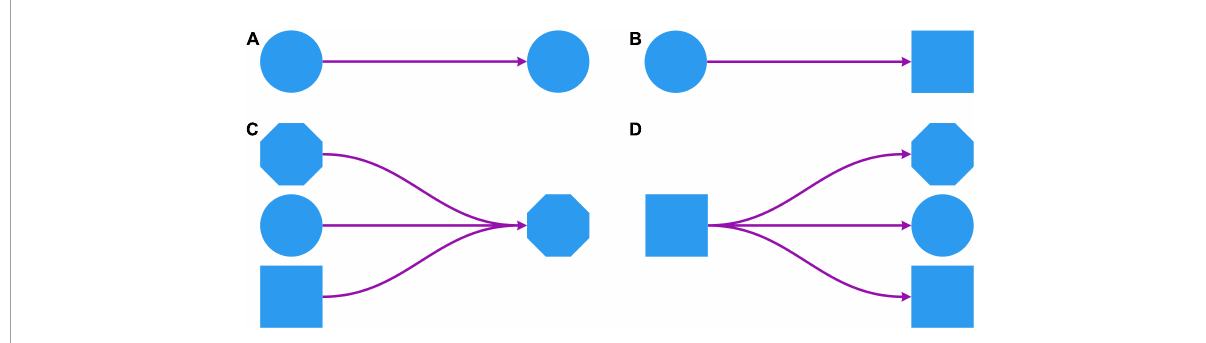
FIGURE6 Examples of events connecting tasks; real to real (A) , real to virtual (B) , mixed, real, and virtual to mixed (C) , and virtual to mixed, real, and virtual (D) .